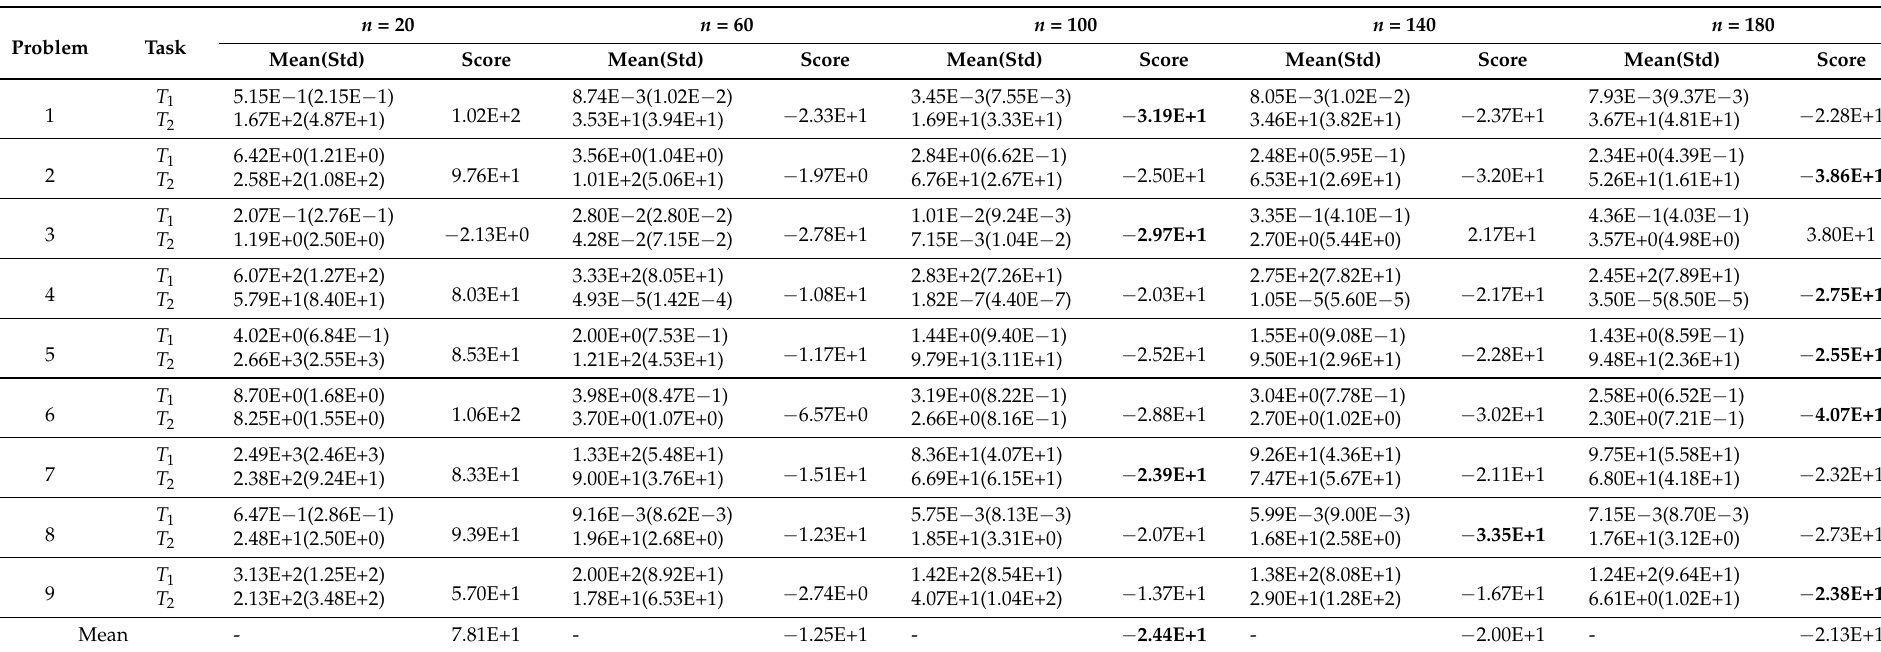
Table 7. Achieved best FEVs (the mean, the bracketed standard deviations and the scores) by the SRPSMTO using different population size ( n ) settings. The better results are shown in